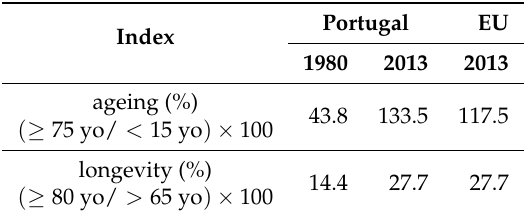
Table 1. Evolution of the ageing and longevity indices, in Portugal, comparing the values for 1980 and 2013. The European Union (EU) values are provided as a reference for the European panorama. Source: